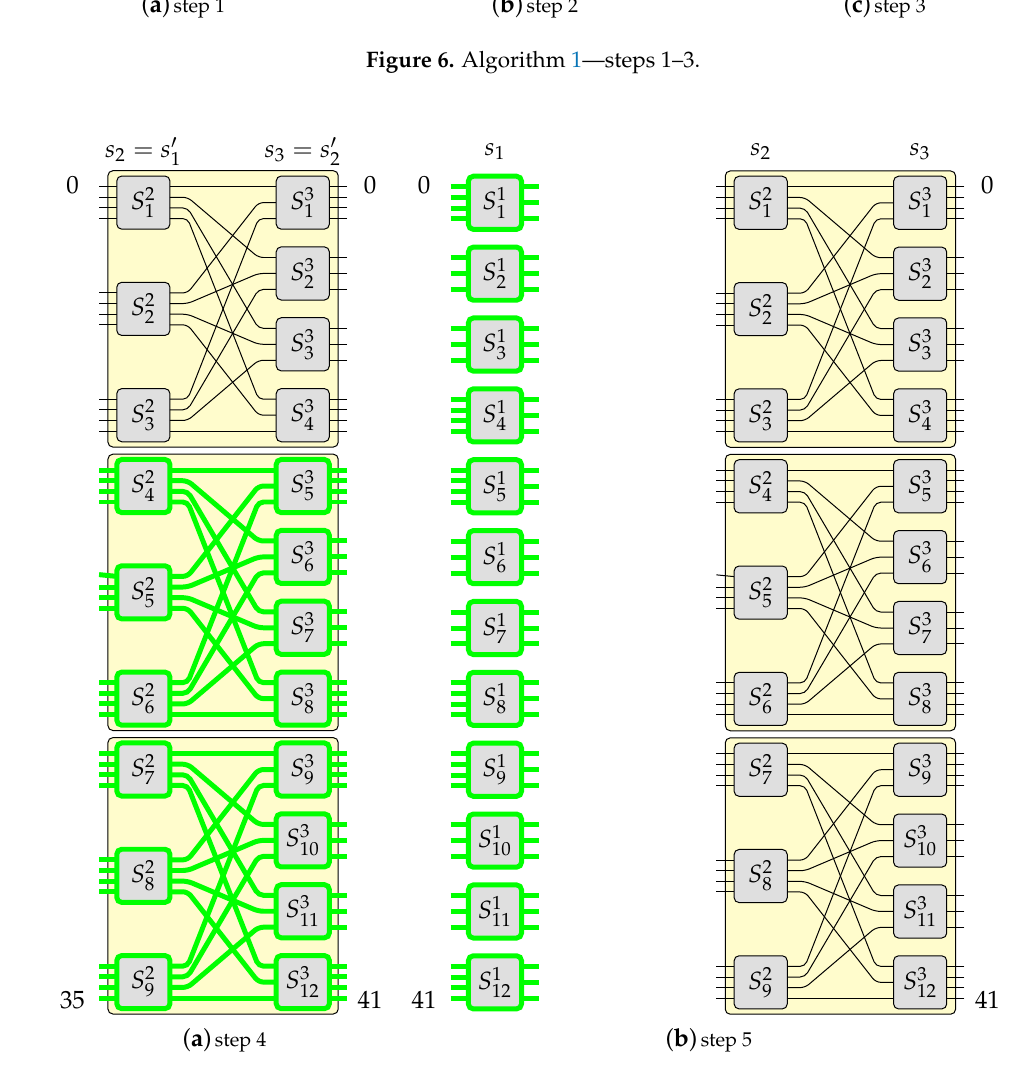
Figure 7. Algorithm 1—steps